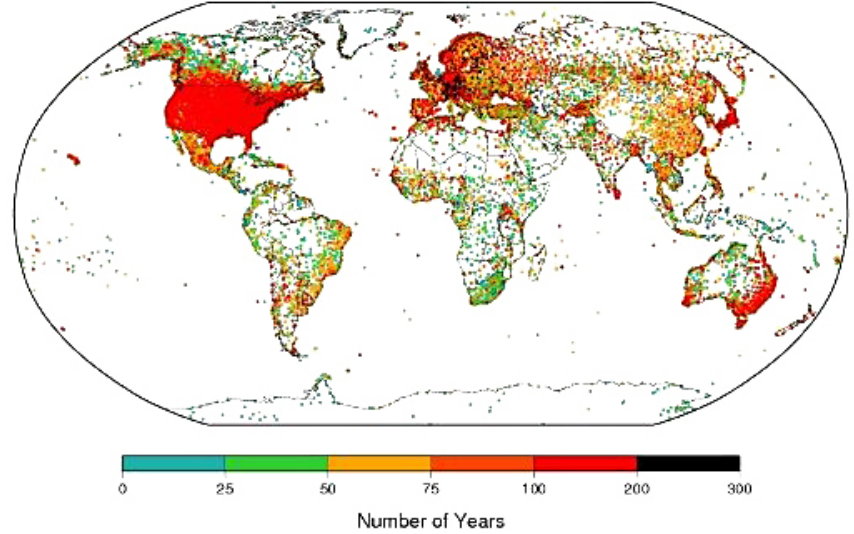
Figure 1. Station locations coloured by length of record for version1 of the ISTI Land Meteorological Databank stage 3 (recommended merged version) version 1.0.0 (source: Fig. 8 in Rennie et al.,